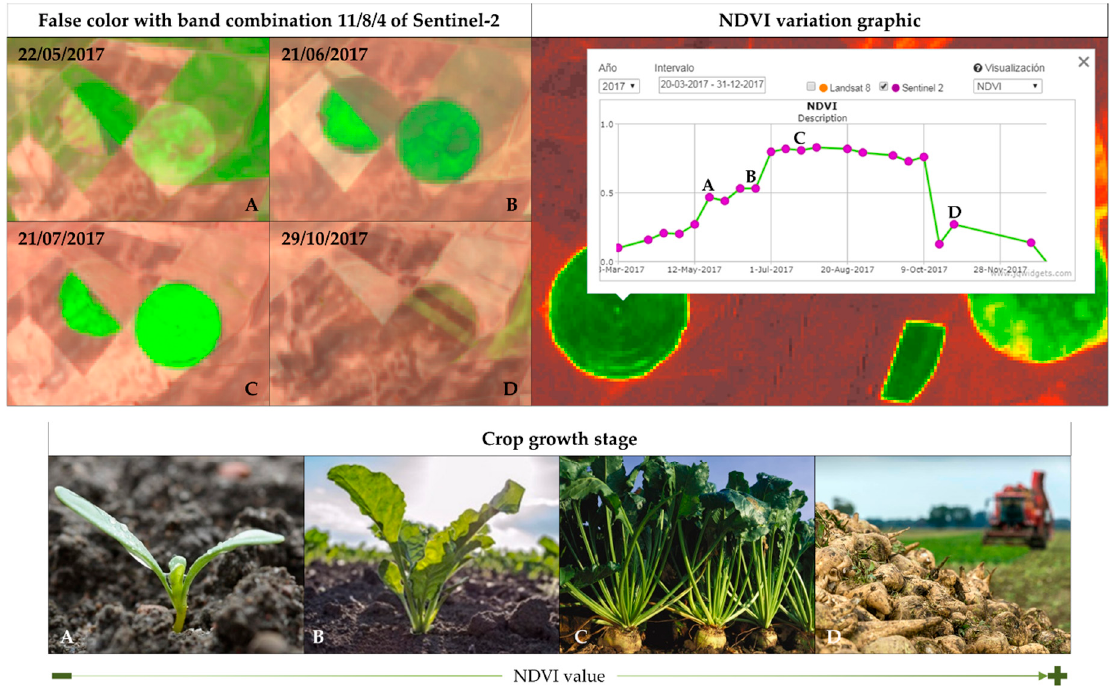
Figure 9. False color images from Sentinel-2 (combination of bands 11, 8 and 4) and a graph of the variation of NDVI TOA values for different dates. This graph represents the growing season profile, including phenological stages, of a sugar beet crop.